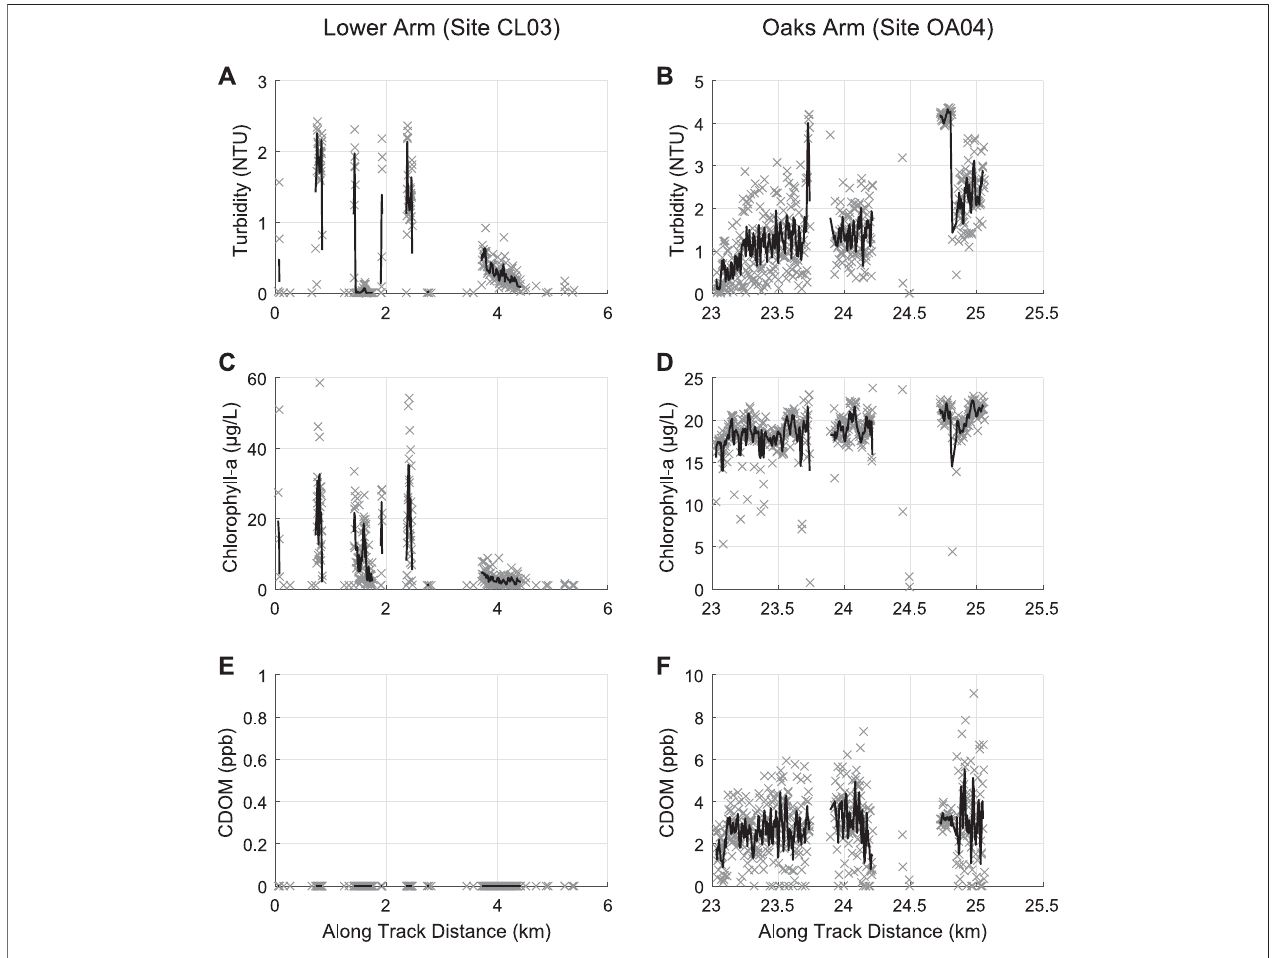
FIGURE 7 | AUV data results for (A, B) turbidity (NTU) (C, D) chlorophyll- a ( μ g/L), and (E, F) CDOM (ppb) for (A, C, E) the Lower Arm and (B, D, F) the Oaks Arm. Running averages (5 consecutive results) are shown for each plot in black. Turbidity is higher in the Oaks Arm than the Lower Arm. The maximum chlorophyll- a concentrations are higher in the Lower Arm while the average concentrations are roughly twice as high in the Oaks Arm. CDOM values were zero in the Lower Arm and averaged 2.7 ppb in the Oaks Arm.